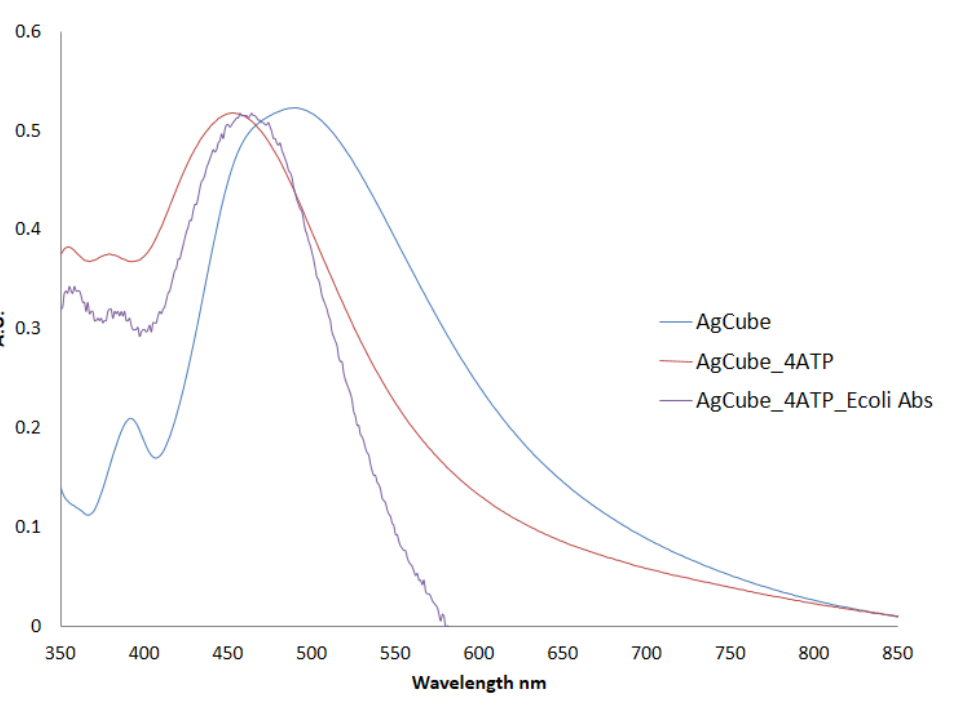
Figure S2. Extinction spectra of of silver nanocube (PVP coated), 4-ATP-coated silver nanocube, and antibody-functionalized silver-nanocube probes.